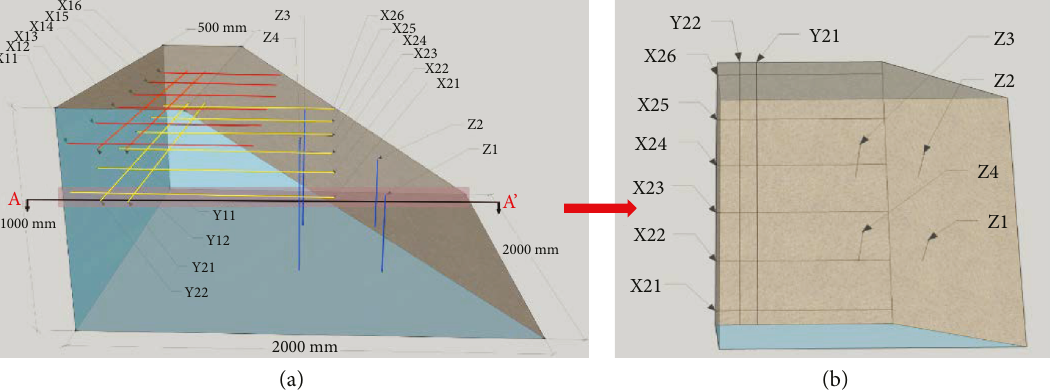
Figure 4: Three-dimensional plan for the laying of sensing optical fi bers. (a) Three-dimensional schematic diagram. (b) A-A ’ cross-section drawing.